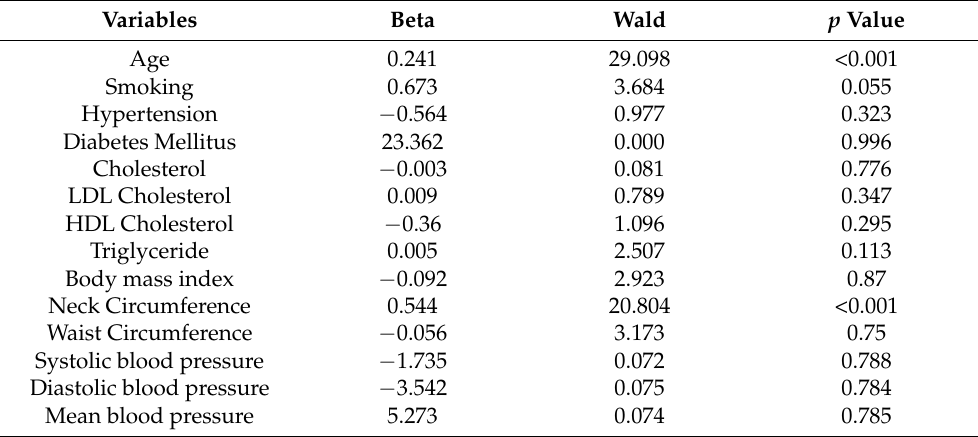
Table 5. The result of multivariate logistic regression analysis for the prediction of the SCORE risk model. Variables Beta Wald p